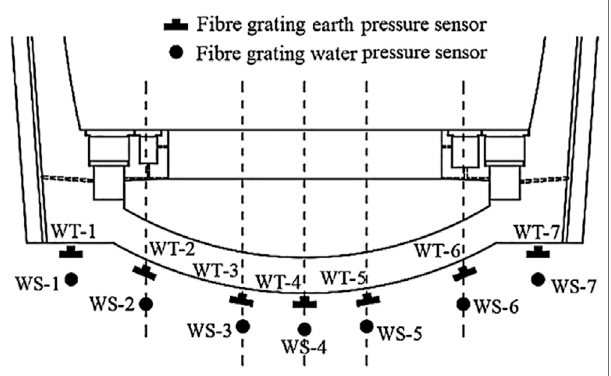
FIGURE 2 | Schematic layout of bottom surrounding rock sensors.